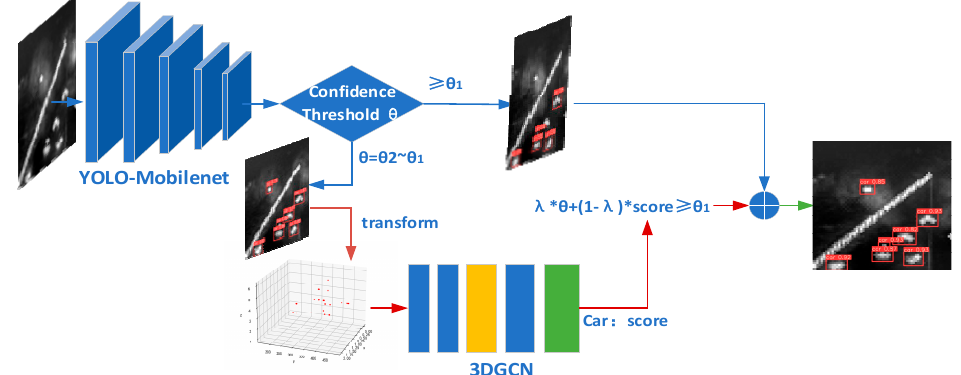
Figure 6. Two-level detection network structure.